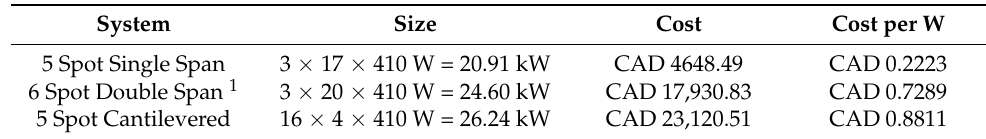
Table 7. Cost per W for each system in CAD.